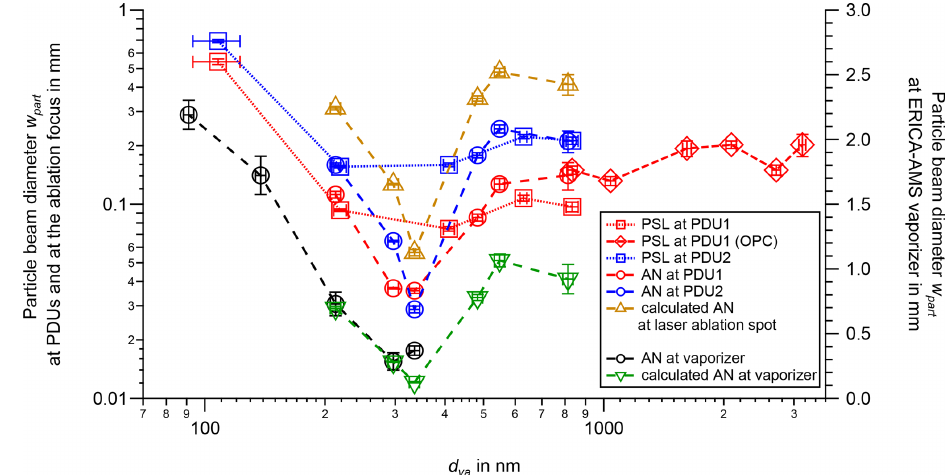
√ e diameter) as a function of particle size d va for PSL (squares) and AN (circles) particles Figure 3. The particle beam diameter w part (1 / measured at the detection units PDU1 (red, left ordinate) and PDU2 (blue, left ordinate) and for AN particles measured at the ERICA-AMS vaporizer (right ordinate, black). The reference values for number concentrations were obtained from the experimental setup with either the CPC or the OPC (Setup B or Setup C, respectively; see Fig. S8 in the Supplement). The AN particle beam diameter at the ablation spot (brown triangles, left ordinate) and the ERICA-AMS vaporizer (green triangles, right ordinate) were calculated by extrapolation of the measurement at PDU2. The uncertainty in PSL particle size is given by NIST certificates and converted to d va . The uncertainty in AN particle size d va is estimated to be 3% (Hings, 2006). These uncertainties for PSL and AN particle sizes are the same for Figs. 3 to 7 and 12. The uncertainties in the particle beam diameters result from the curve fittings (1 standard